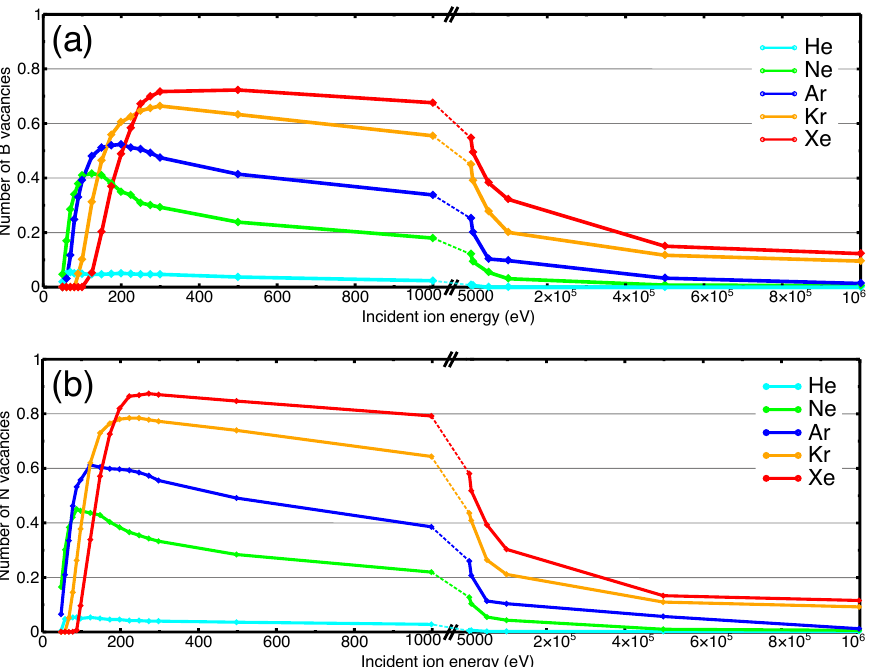
Figure 2. Average number of ( a ) single B vacancies, and ( b ) single N vacancies in h-BN monolayer created under irradiation with various inert gas ions. The apparent ‘kink’ at ion energies about 5 keV is just a visual effect originating from the transition from linear to logarithmic